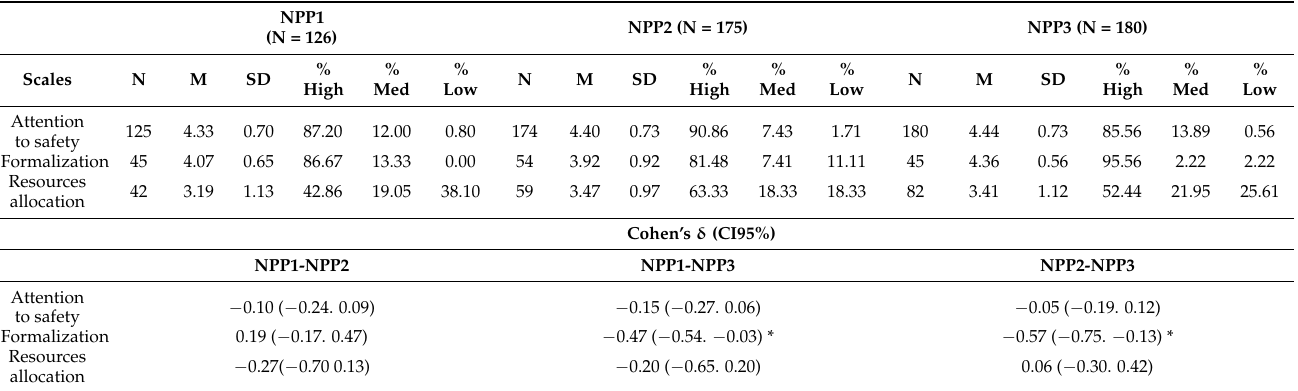
Figure 5. BARS averages by company.